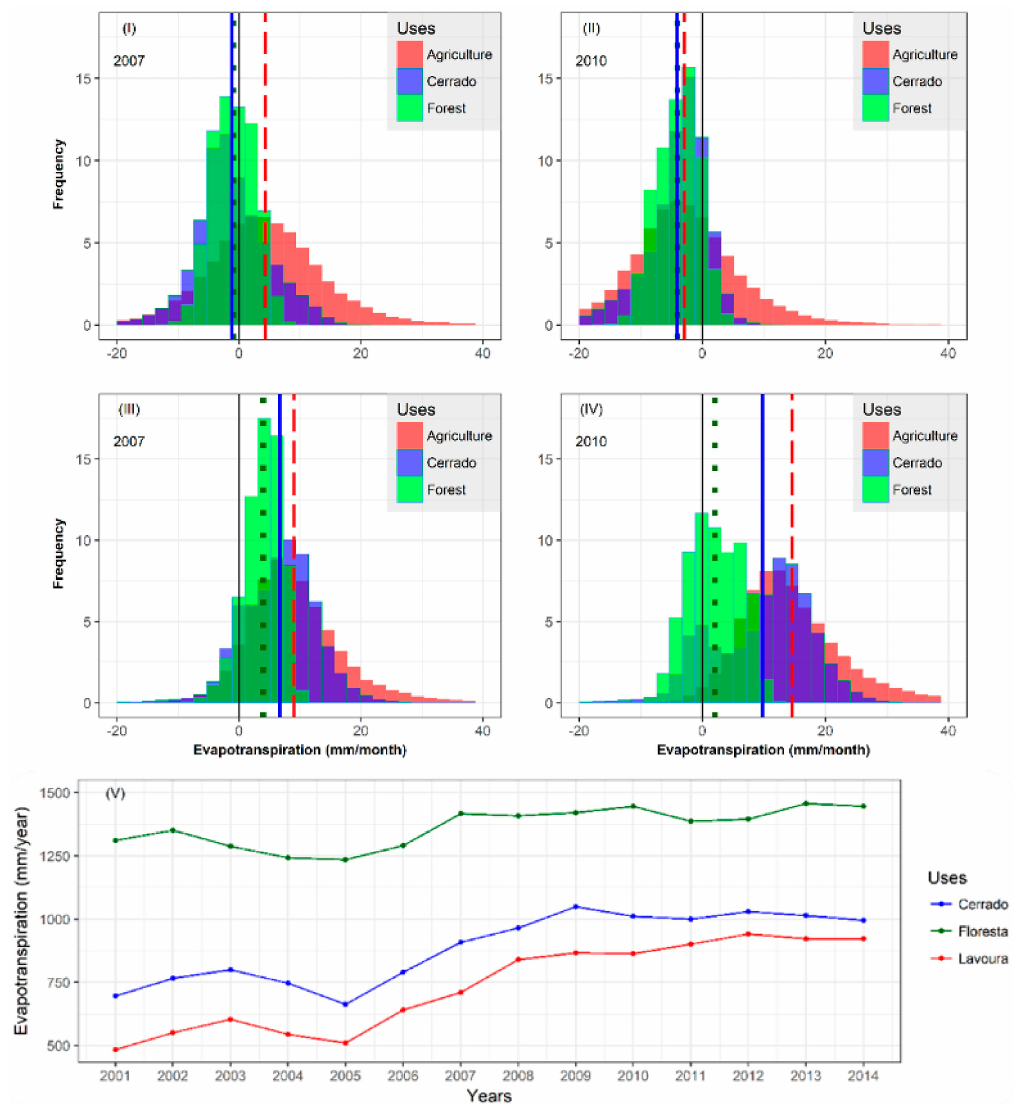
Figure A3. Histograms of the variation in the evapotranspiration of the principal land cover types in the Brazilian state of Mato Grosso during the drought events of 2007 and 2010. The dotted lines (green = forest; blue = savanna; red = cropland) represent the means recorded in each type of land cover. In graphs ( I , II ), ∆ e is the di ff erence between the mean for the year of extreme drought ( Ae ) and the biannual mean ( b ). In graphs ( III , IV ), ∆ e is the di ff erence between the mean for the year of extreme drought ( Ae ) and the historical mean ( b ). Graph ( V ) shows the variation in the evapotranspiration between 2001 and